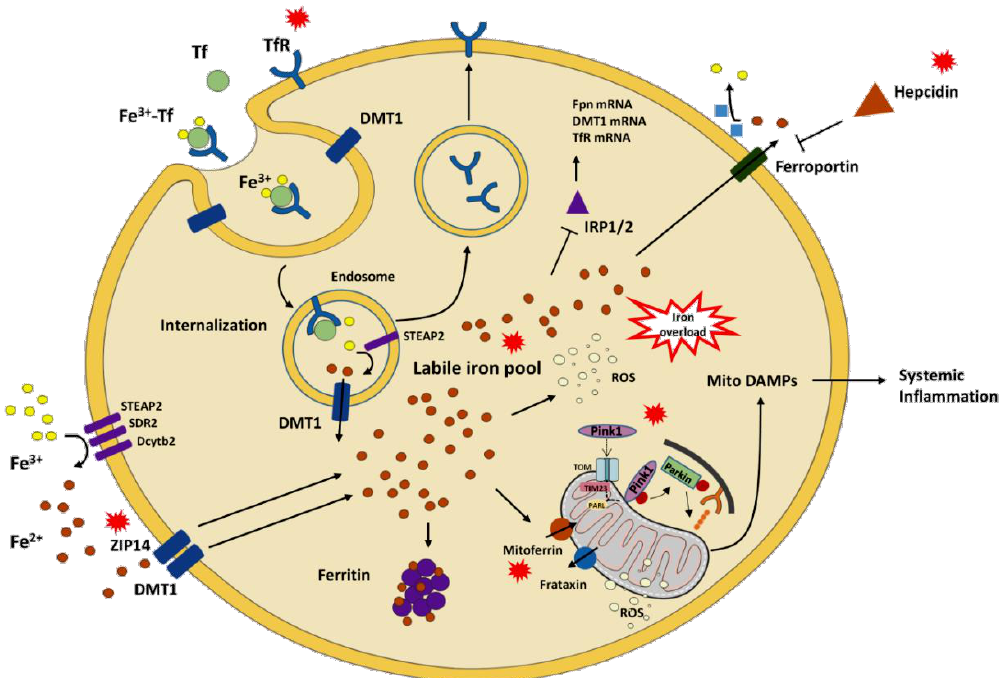
Figure 7. Schematic representation of putative pathways linking age-related systemic and muscular iron dyshomeostasis, derangements in mitochondrial quality control, and systemic inflammation. Red callouts indicate mediators / processes that are mainly dysregulated. Abbreviations: DAMPs, damage-associated molecular patterns; Dcytb2, duodenal cytochrome b2; DMT1, divalent metal transporter 1; Fpn, ferroportin; IRP1 / 2, iron-responsive element-binding protein 1 / 2; PARL, presenilin-associated rhomboid-like protein; Pink1, phosphatase and tensin homolog-induced kinase 1; ROS, reactive oxygen species; SDR2, stromal cell-derived receptor 2; STEAP2, six-transmembrane epithelial antigen of the prostate 2; Tf, transferrin; TfR, transferrin receptor; TIM23, translocase of inner mitochondrial membrane 23; TOM, translocase of the outer mitochondrial membrane; ZIP14, Zrt-Irt-like protein 14.